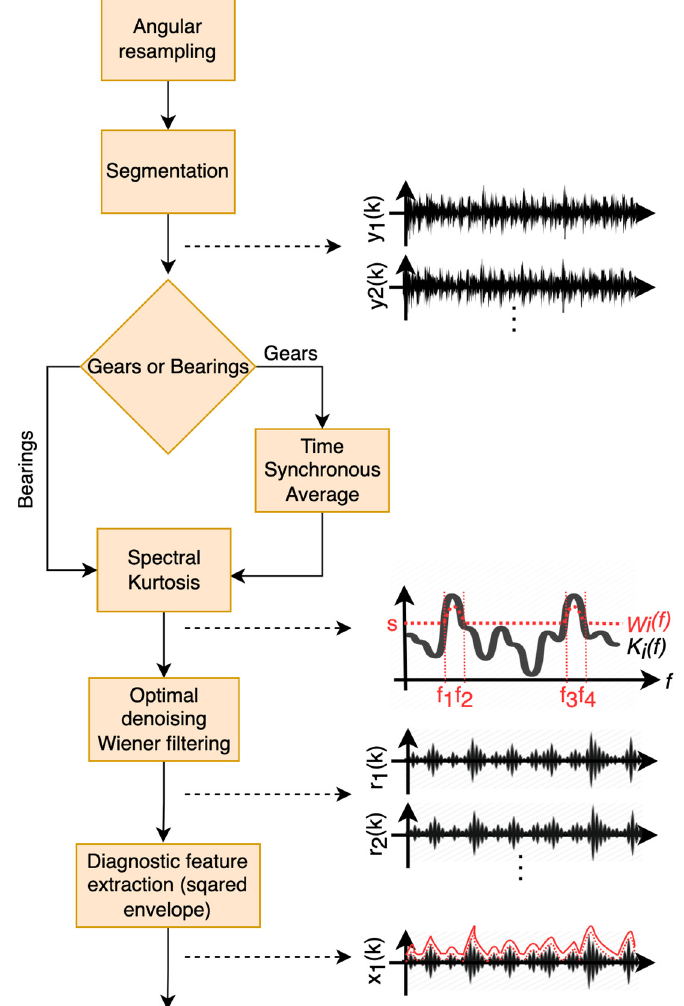
Figure 1. Schematic of the technology for extraction of gearbox/bearing diagnostic